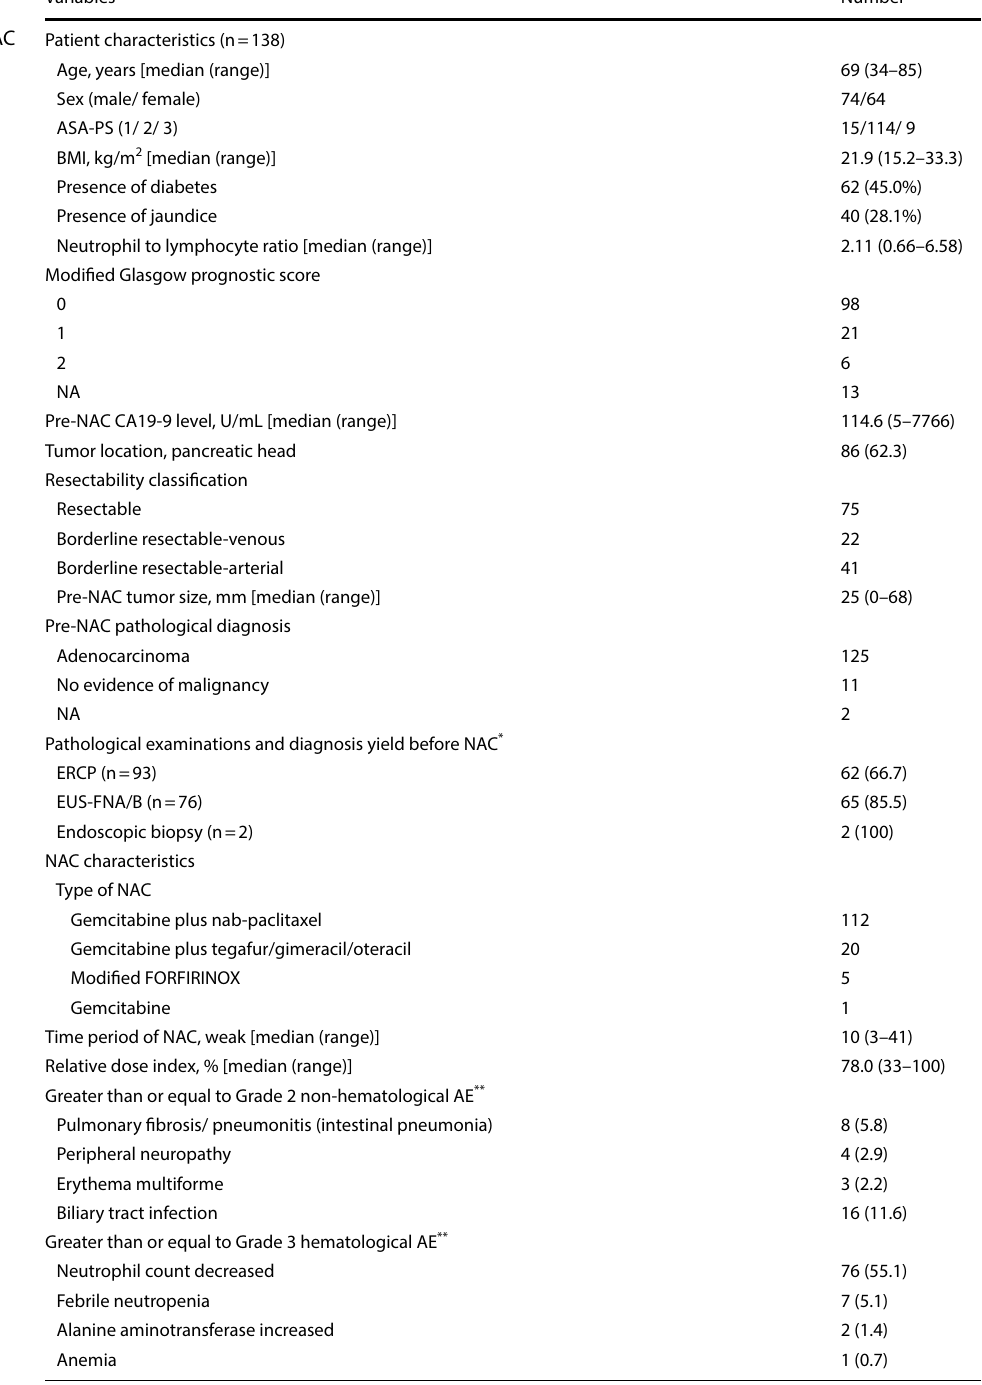
Table 1 Patient characteristics before neoadjuvant chemotherapy (NAC) and NAC